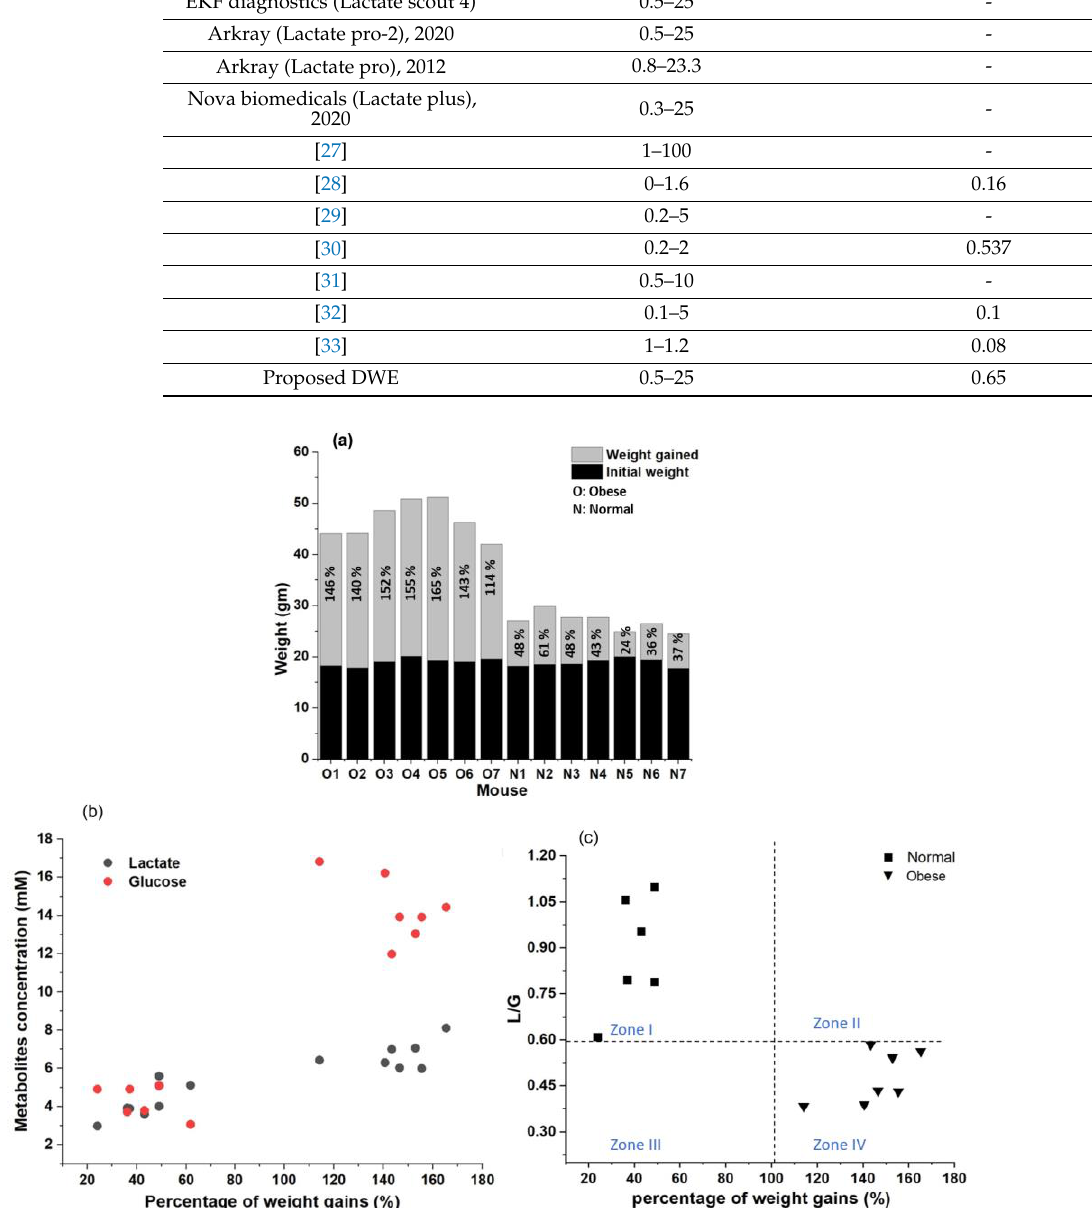
Figure 5. Efficiency test: ( a ) a bar graph displaying body weight gains in obese and normal mice. ( b ) Spotted plot of blood glucose ( ●) and lactate (●) concentrations with respect to percentages of weight gains. ( c ) Spotted plots of lactate to glucose ratio (L/G) calculated from plot ( b ) with respect to the percentage of weight gain. Here, the symbols ■ and ▼ represent normal and obese mice, respectively. All measurements (percentage of weight gains, and blood glucose and lactate) were performed after 28 weeks of diet (normal or HFD). The L/G plot is divided into four subsections: zone I, zone II, zone III, and zone IV in ( c ).